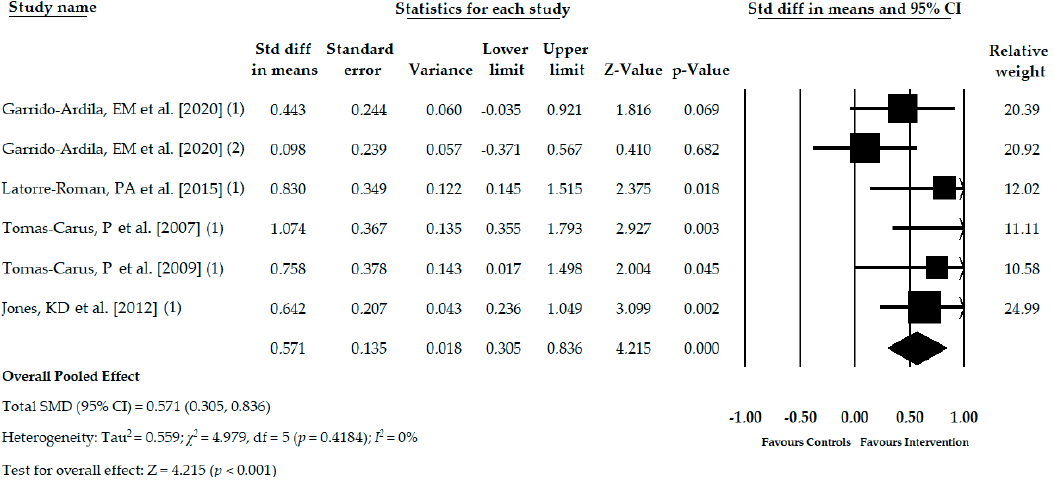
Figure2. Forestplotofthemeta-analysisoftheimmediatee ff ectoftheATBTinmonopedalstaticbalance. Figure 2. Forest plot of the meta-analysis of the immediate effect of the ATBT in monopedal static balance .